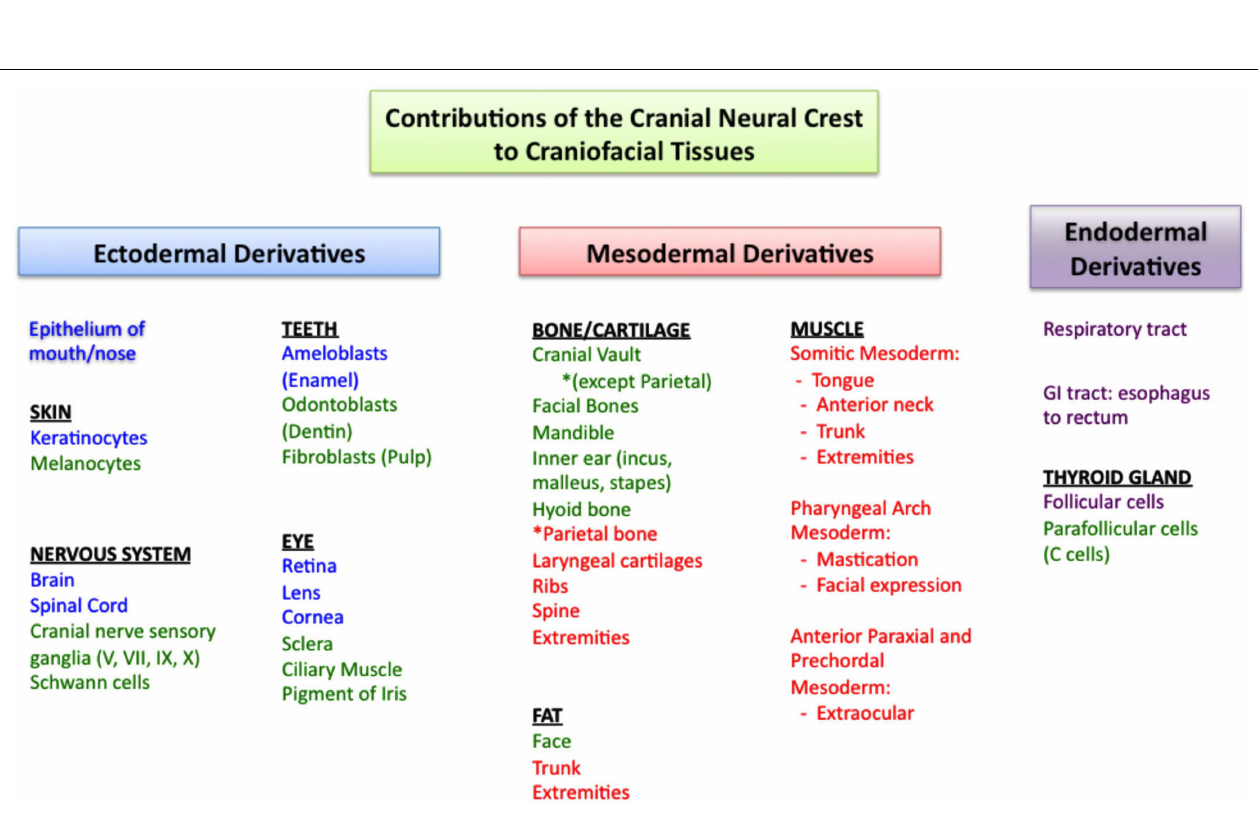
FIGURE 1 | Cranial neural crest cells have unique contributions to tissues of the face and head. Ectodermal derivatives are in blue, mesodermal derivatives in red, and endodermal derivatives in purple. In green are the components of these tissues that develop primarily from cranial neural crest cells. In the face and head, cranial neural crest cells contribute to bone,